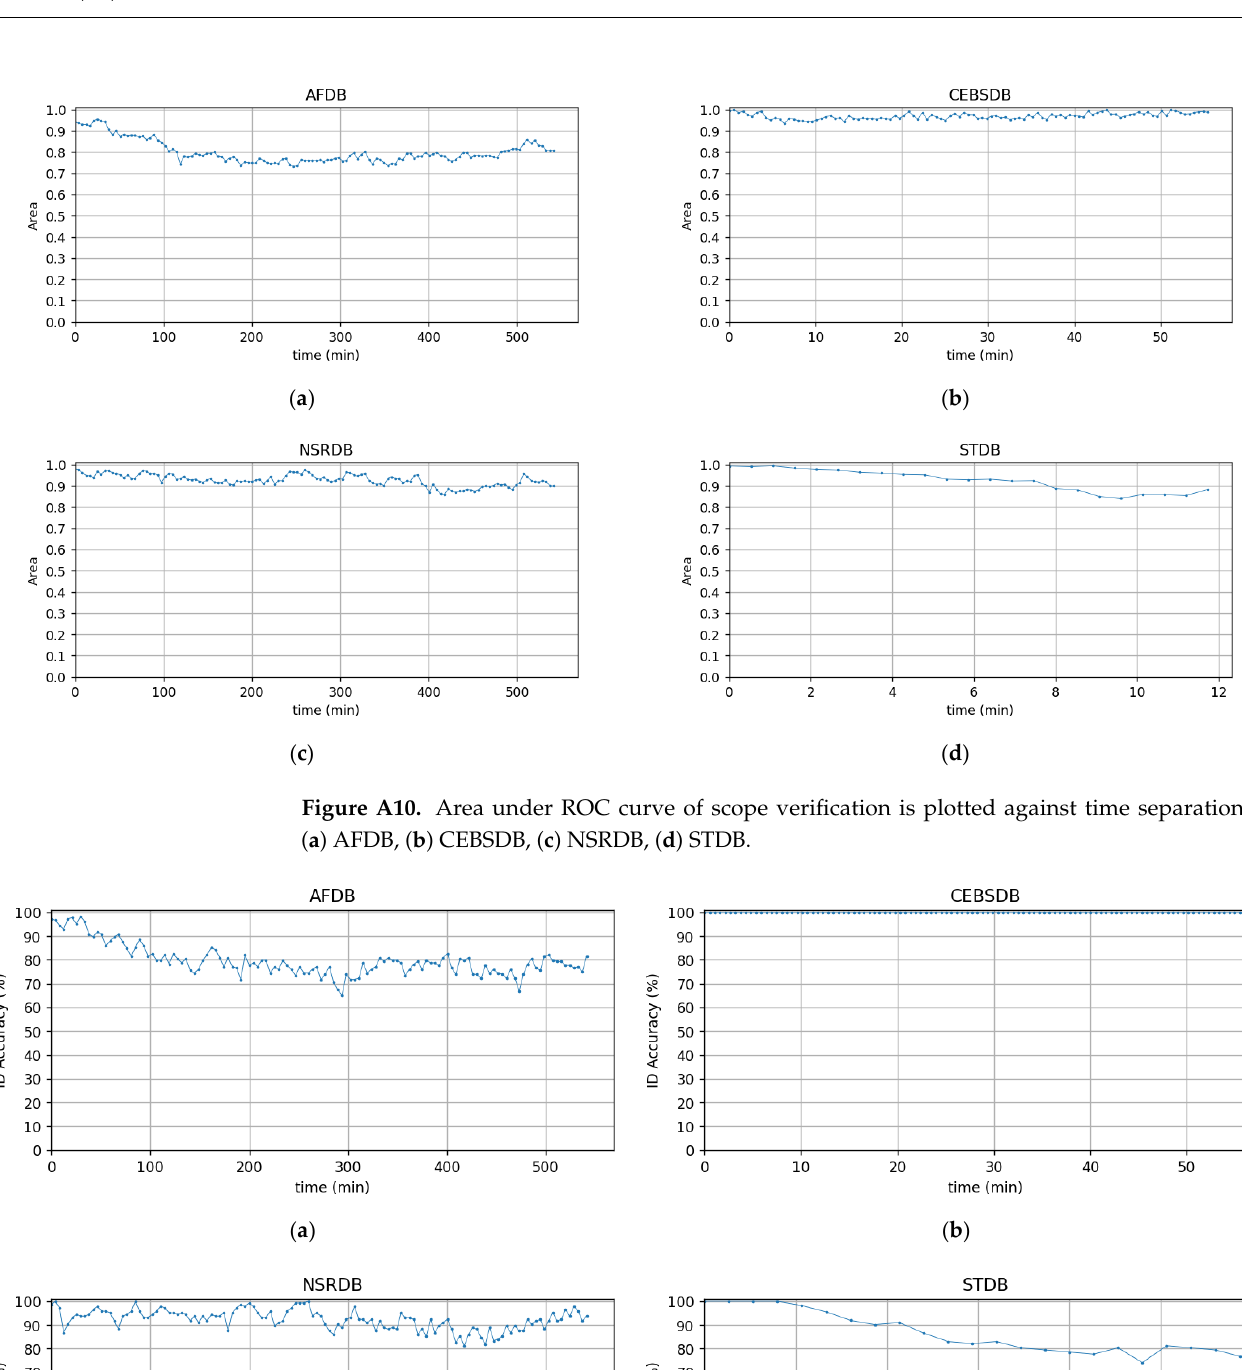
Figure A9. EER of scope verification is plotted against time separation for: ( a ) AFDB, ( b ) CEBSDB, ( c ) NSRDB, ( d ) STDB.